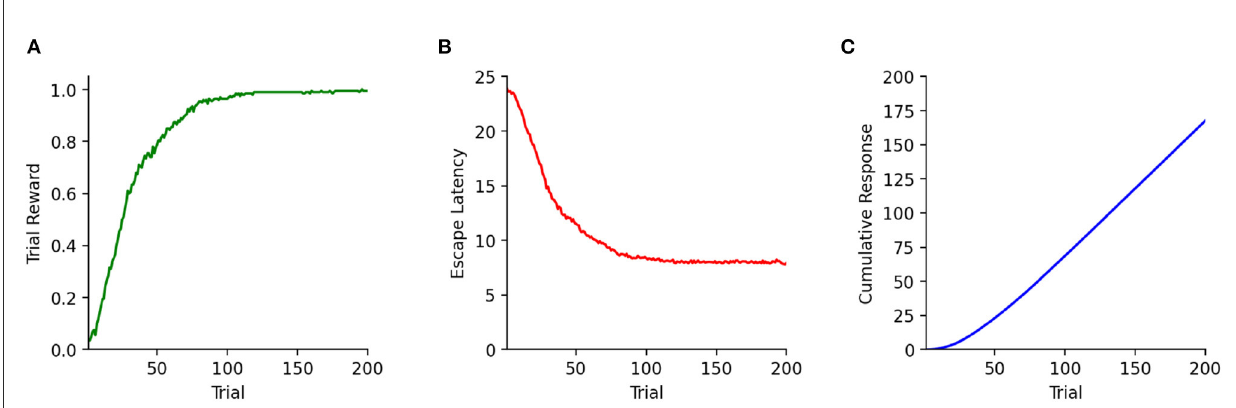
FIGURE5 Commonly needed monitors in CoBeL-RL. (A) The reward monitor tracks the cumulative reward collected during each trial. (B) The escape latency (in number of trial steps) can be tracked with the escape latency monitor. (C) The response monitor can track the cumulative responses emitted by the agent. Per default responses are coded with one when a reward was collected and zero otherwise. The coding of responses can be customized by using the simulation loop’s callback